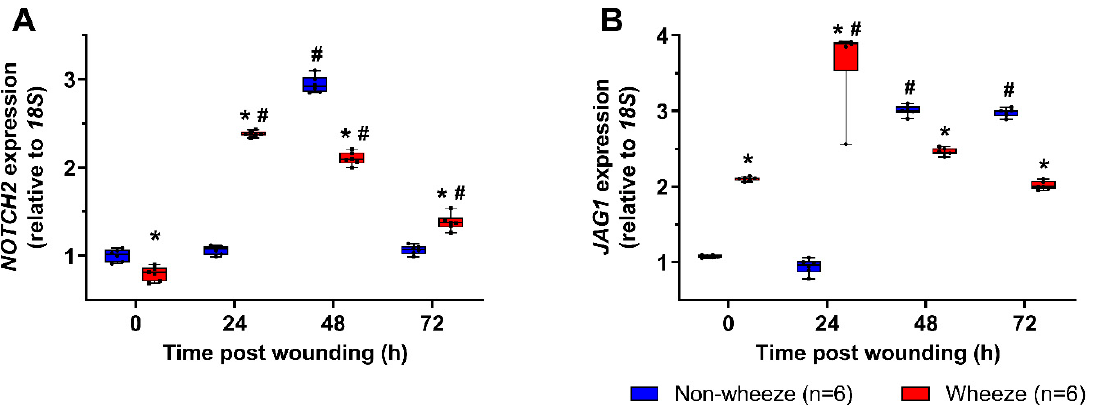
Figure 4. NOTCH2 and JAG1 gene expression profiles in pAEC post in vitro wounding. Relative expression of NOTCH2 ( A ) and JAG1 ( B ) mRNA were measured in pAEC post in vitro wounding from children with ( n = 6) and without wheeze ( n = 6) by real-time qPCR. ( A , B ) Following wounding, pAEC from children without wheeze displayed a significant upregulation of NOTCH2 and JAG1 mRNA expression at 48 h post wounding respectively. By 72 h post wounding, NOTCH2 mRNA expression ( A ) had returned to baseline levels, whilst JAG1 mRNA expression ( B ) was maintained at about 3-fold higher levels than baseline. In contrast, pAEC cultures from children with wheeze displayed lower gene expression levels of NOTCH2 (A) and higher gene expression levels of JAG1 ( B ) at baseline. An earlier induction of NOTCH2 mRNA expression was observed in pAEC from children with wheeze at 24 h post wounding, which was sustained to 72 h post wounding. Although JAG1 mRNA levels were induced by 24 h post wounding, JAG1 expression returned to baseline levels by 72 h post wounding indicating distinct differences in the kinetics of Notch signaling during airway epithelial repair in children with wheeze. Data are represented as median ± IQR. * Statistical significance of the wheeze group relative to matching non-wheeze timepoint sample ( p < 0.050; Mann–Whitney U-test), or # statistical significance of relevant timepoint to time 0 h of matching patient cohort ( p < 0.050; Kruskal–Wallis test with Dunn’s test for multiple comparisons).